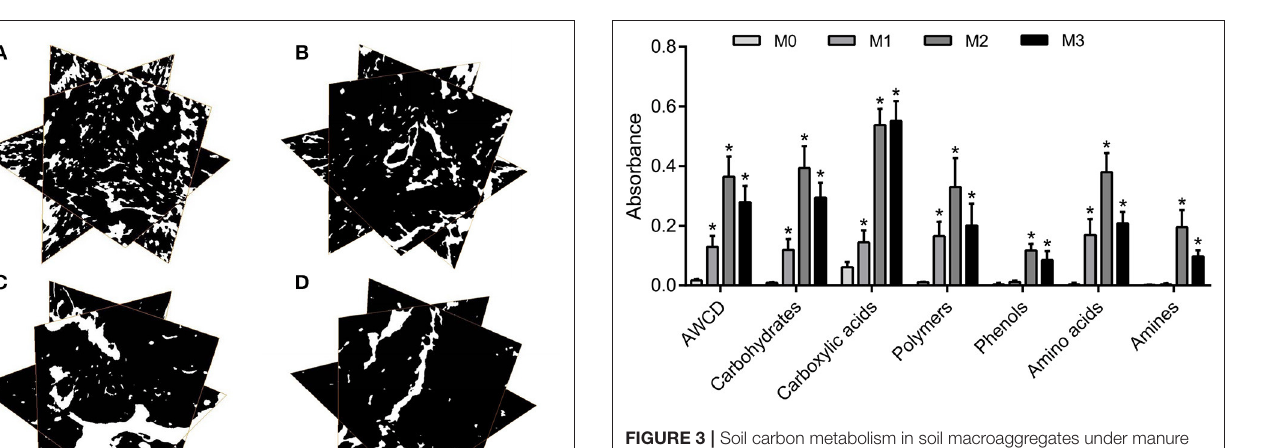
FIGURE 3 | Soil carbon metabolism in soil macroaggregates under manure treatments. Microbial carbon metabolic activities in soil macroaggregates are reflected by the average well color development (AWCD) under manure treatments. The carbon sources are further subdivided into six substrate groups including carbohydrates, carboxylic acids, amino acids, polymers, phenolic acids, and amines. Bars with * indicate significant differences ( P < 0.05) between manure additions and the M0 treatment, as revealed by one-way ANOVA with Bonferroni’s post-hoc test. M0, no manure; M1, low manure; M2, high manure; M3, high manure plus